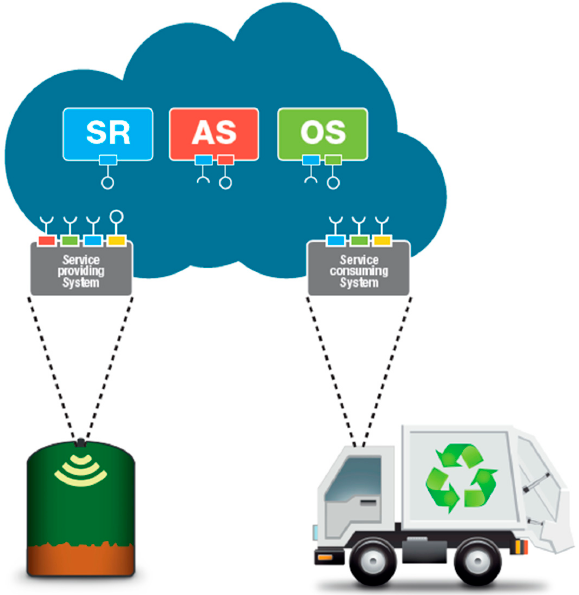
Figure 3. Architecture used/adapted for a recycling management context.